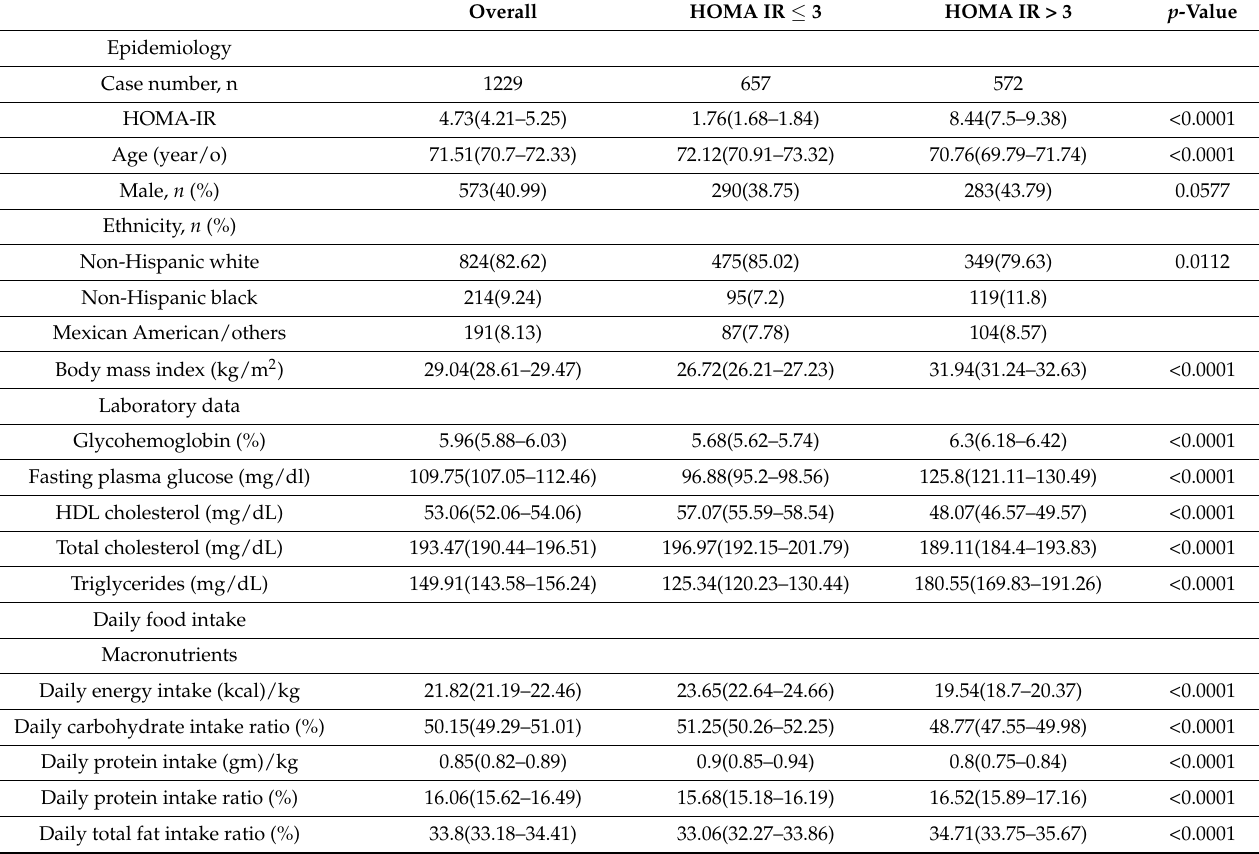
Table 1. Baseline characteristics of all participants with chronic kidney disease according to